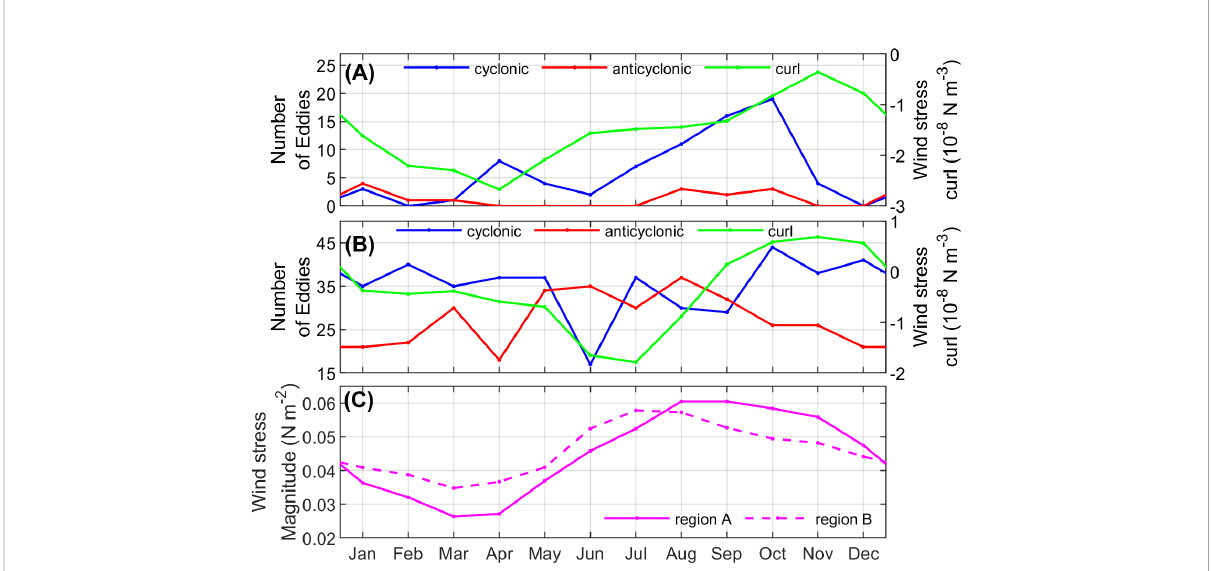
FIGURE 7 Seasonal cycle of (A) number of AE and CE (red and blue lines respectively) and wind stress curl (green line) within northern part of NEB (region A), (B) number of AE and CE (red and blue lines respectively) and wind stress curl (green line) within southern part of NEB (region B), and (C) wind stress magnitude in regions A (magenta solid line) and B (dashed magenta